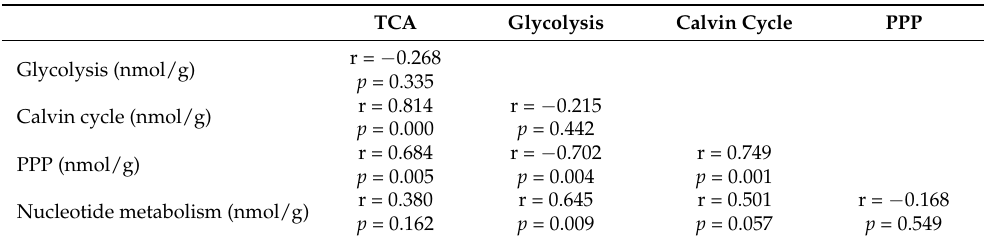
Figure 7. A two-dimensional principal component analysis biplot showing relationships amongst the total metabolites involved in the Calvin cycle, glycolysis, pentose phosphate pathway (PPP), tricarboxylic acid (TCA) cycle, and nucleotide biosynthetic pathway of Mexican mint ( Plectranthus amboinicus ) plants under varying watering regimes. The projection of the variables in the 2D factor space (F1 and F2) explained a total of ca. 96% of the variations in the dataset. Variables that are closely located are not different compared to variables located at a distance within a quadrant or between quadrants (n = 3). Regular watering (RW), drought (DR), resumption of regular watering after drought (RH), flooding (FL), and resumption of regular watering after flooding (DHFL). Table 2. Pearson correlation coe ffi cients (r) amongst the speci fi c central carbon metabolic pathways in Mexican mint ( Plectranthus amboinicus ) under varying watering regimes at a signi fi cance level of p ≤ 0.05.